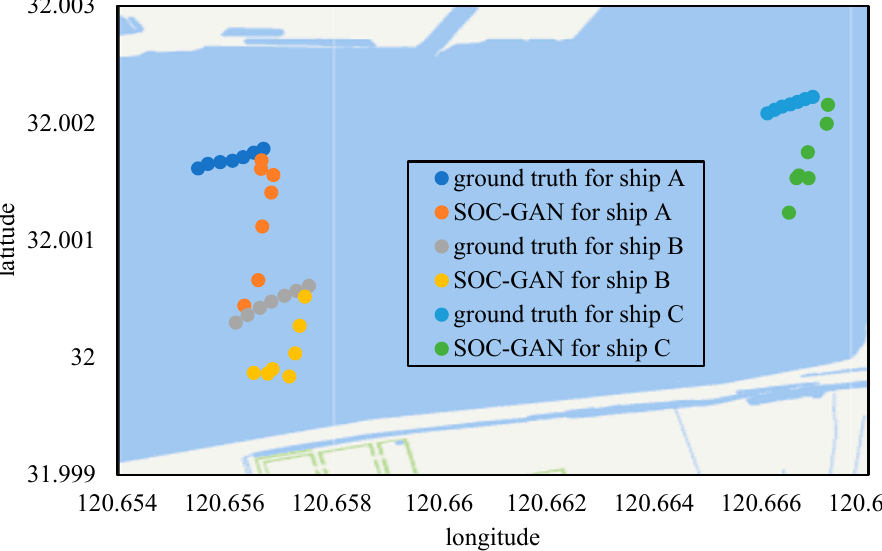
Figure 6. SOC-GAN model prediction performance for different ships.